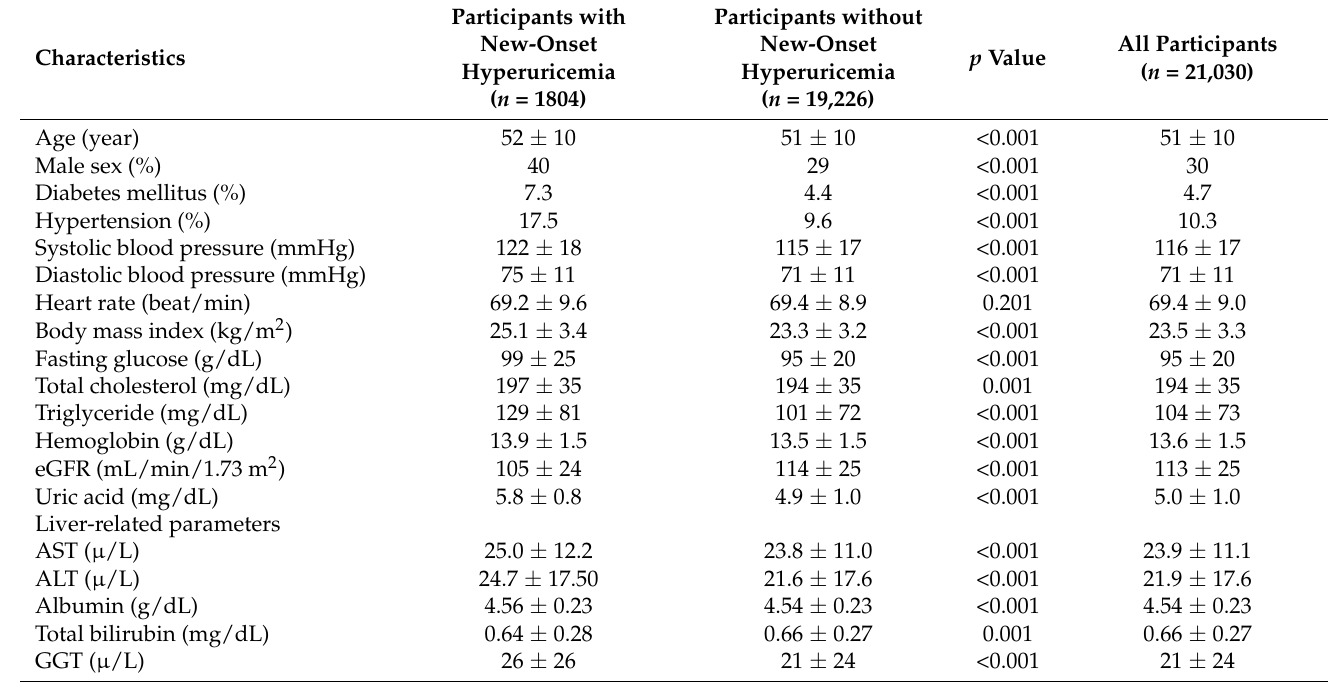
Table 1. Comparison of baseline characteristics between participants with and without new-onset